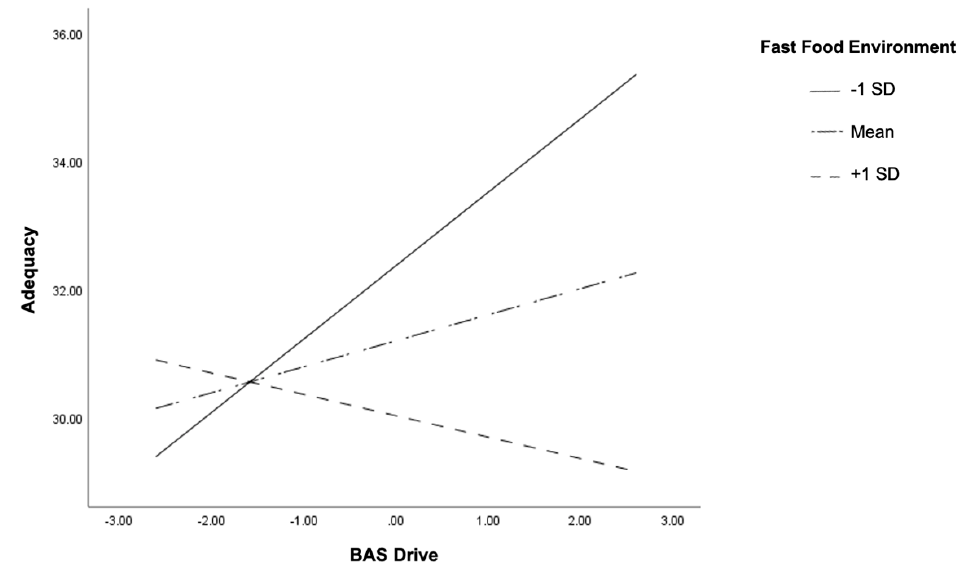
Figure 1. Two-way interaction of BAS drive and fast-food environment in relation to adequacy Healthy Eating Index subscores in early adolescents. High and low levels of the variables are plotted at +1 and − 1 standard deviation from the mean.